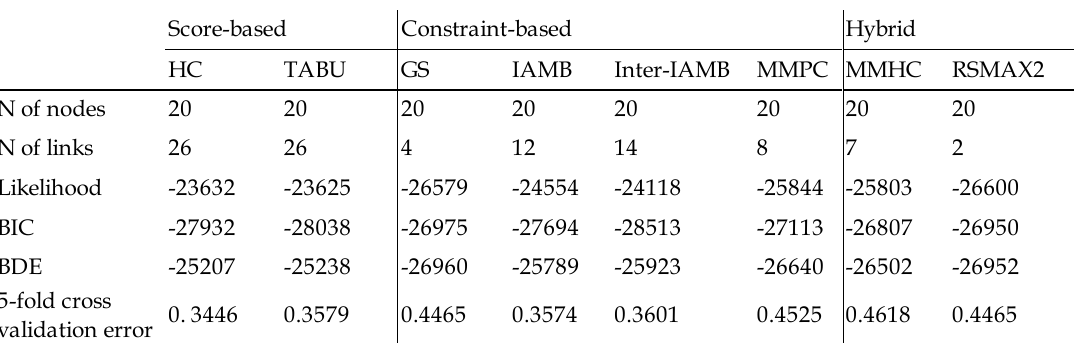
Table 8. Comparison of embedded structure learning algorithms on the obtained